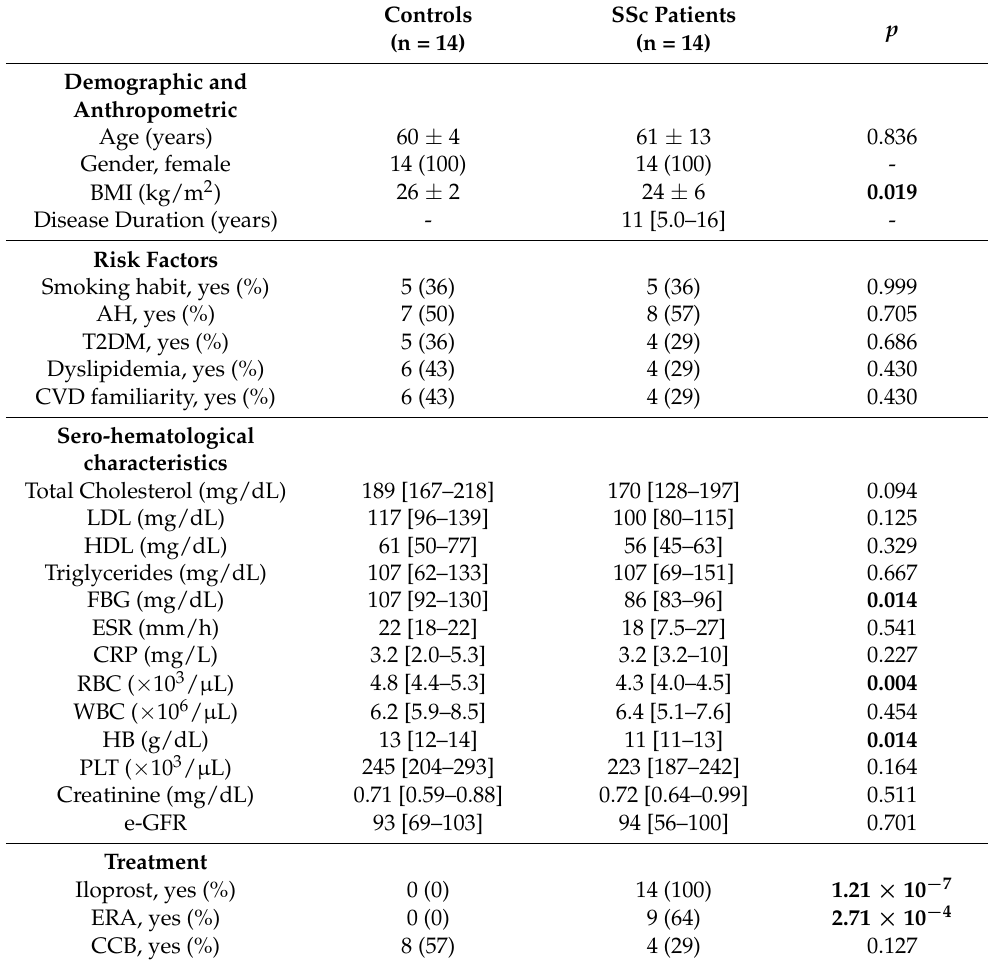
Table 1. Characteristics of the study